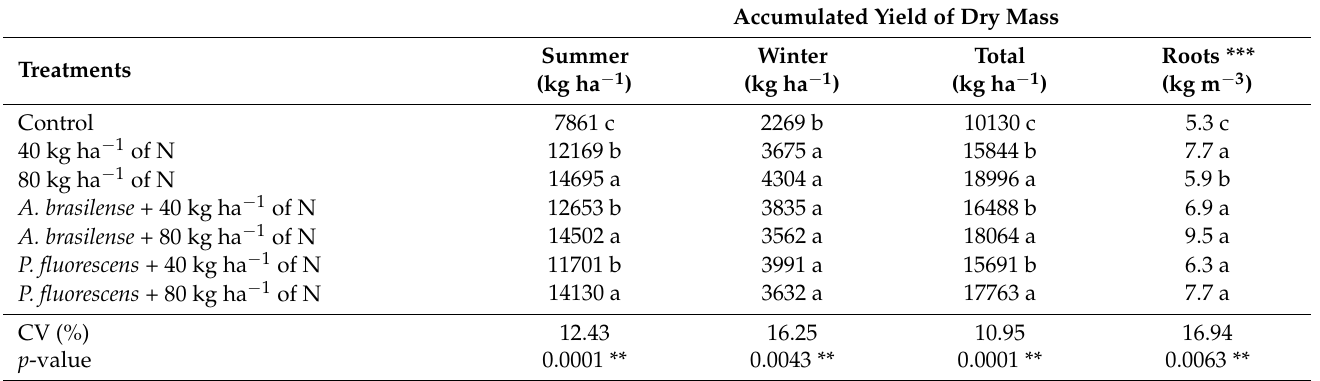
Table 2. Means of accumulated yield of dry mass of the shoots in the summer, winter, and total seasons, and root dry weight yield of Megathyrsus maximus cv. BRS Zuri inoculated with